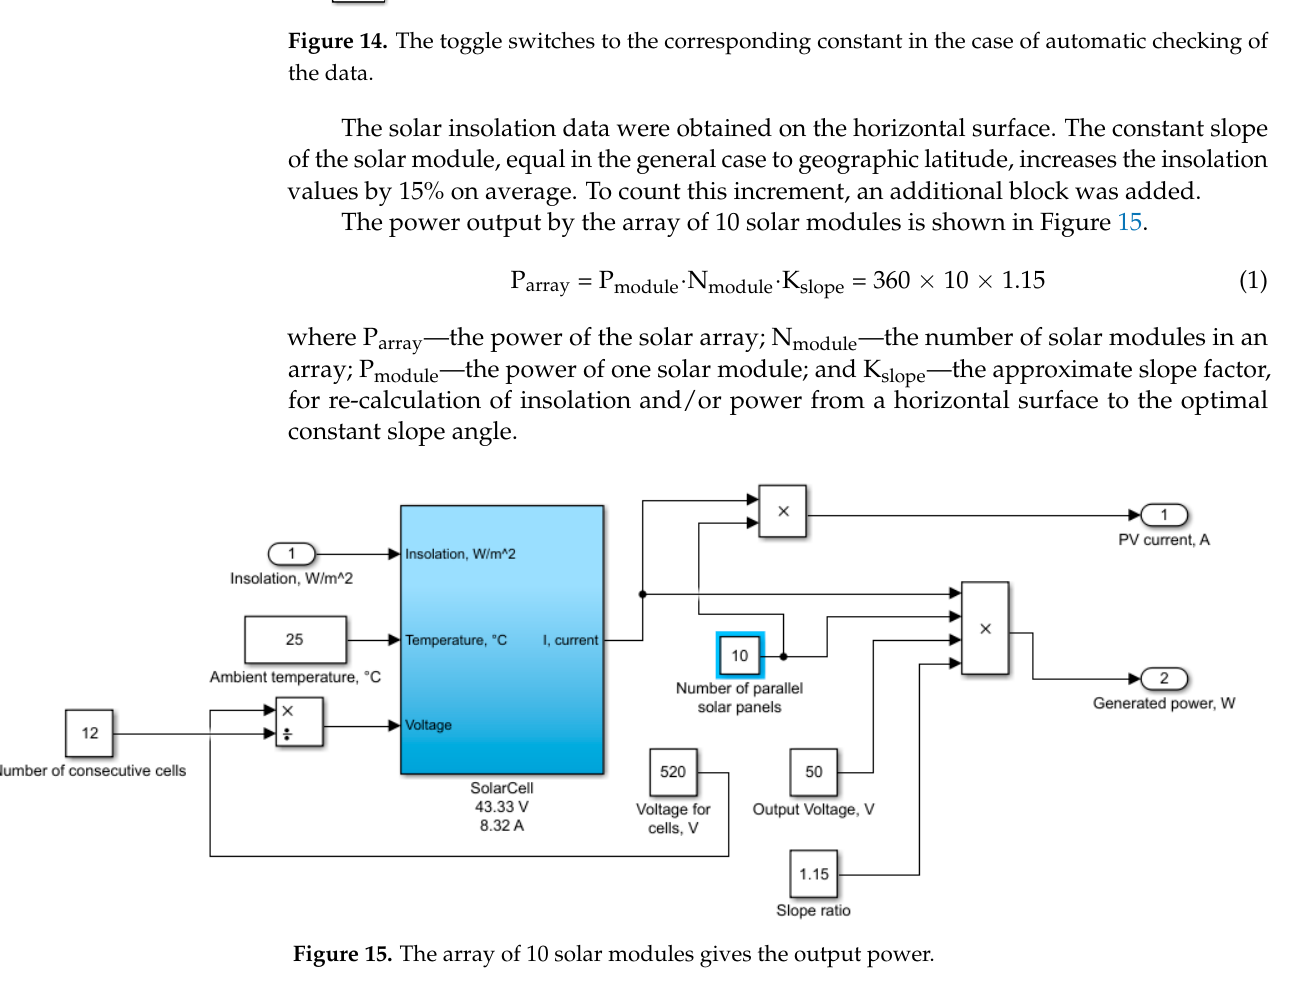
Figure 14. The toggle switches to the corresponding constant in the case of automatic checking of the data.